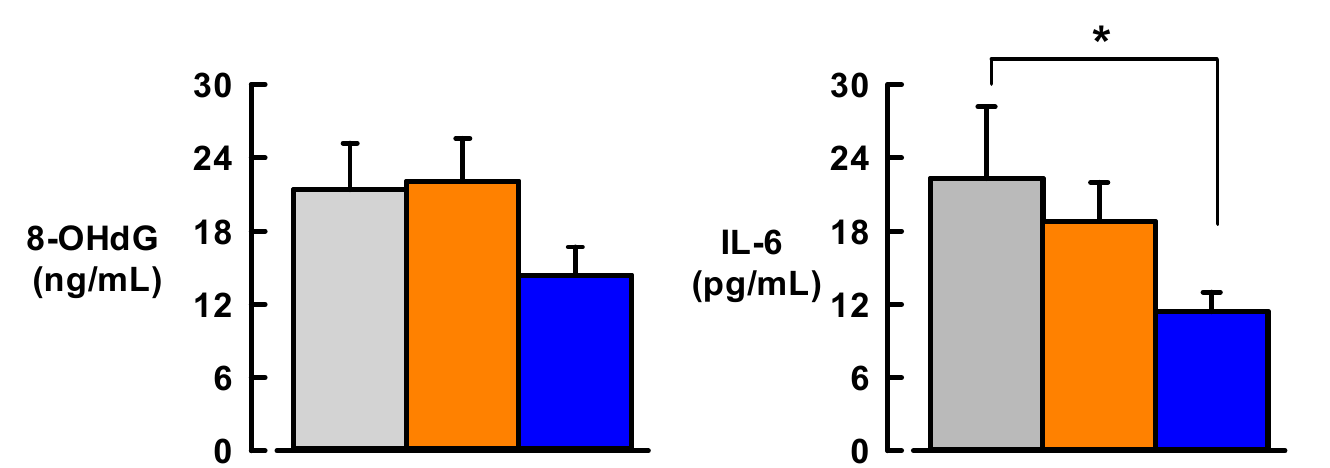
Figure 3. Effect of 12-week Mediterranean diet intervention (blue bars) or usual diet (orange bars) on plasma levels of pro-inflammatory cytokine interleukin-6 (IL-6) and oxidative stress marker 8-hydroxy-2 ′ -deoxyguanosine (8-OHdG) compared with baseline levels (Grey bars) in participants with type 2 diabetes. Sample size, N = 19. Data are mean ± SEM. * p < 0.05, different from baseline.